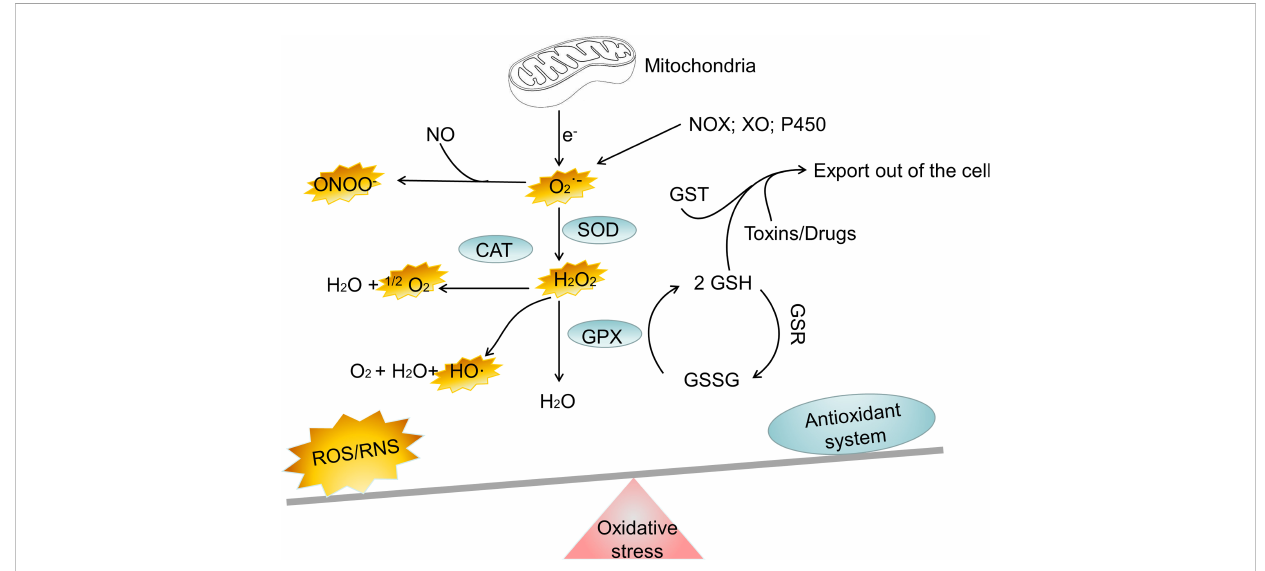
FIGURE 1 The major oxidant and antioxidant systems. NOX, NADPH oxidase; XO, xanthine oxidase; SOD, superoxide dismutase; CAT, catalase; GPX, glutathione peroxidase; GSH, glutathione; GSSG, reduced glutathione; GST, glutathione S-transferase; H 2 O 2 , hydrogen peroxide; ONOO − , peroxynitrite; HO·, hydroxyl radical; O − 2 , superoxide; 1 O 2 , singlet oxygen; Fe 2+ , Iron (II); Fe 3+ , Iron(III); ROS, reactive oxygen species; RNS, reactive nitrogen